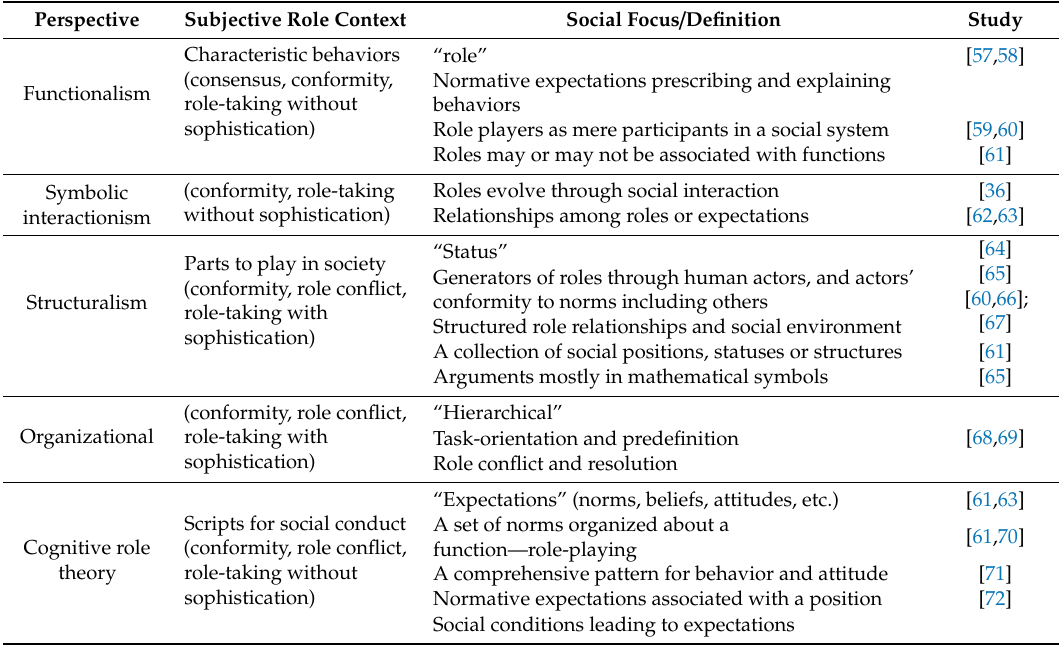
Table 1. Role perspectives in a social system.